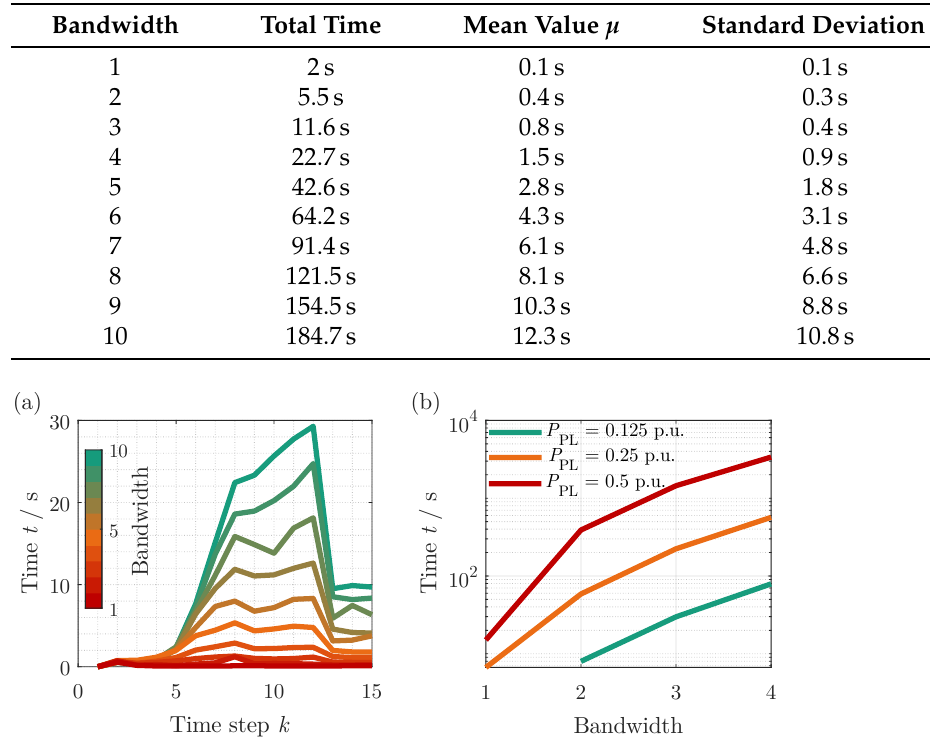
Figure 5. Time step-specific computing speed of the iDP on the bandwidth (1 to 10 in a step size of 1) ( a ) and the total computing speed of the first iteration depending on the discretization of the pre-loop as a function of bandwidth ( b